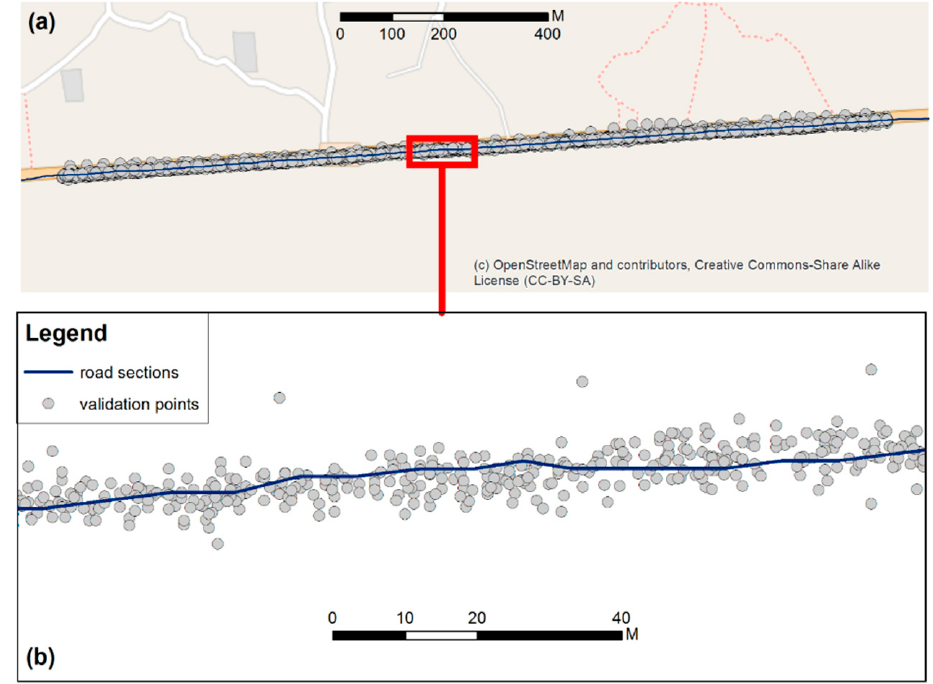
Figure 3. Validation data ( a ) Locations of the full extent of 5381 data points that were used in the verification process. ( b ) A subsection of the datasets.